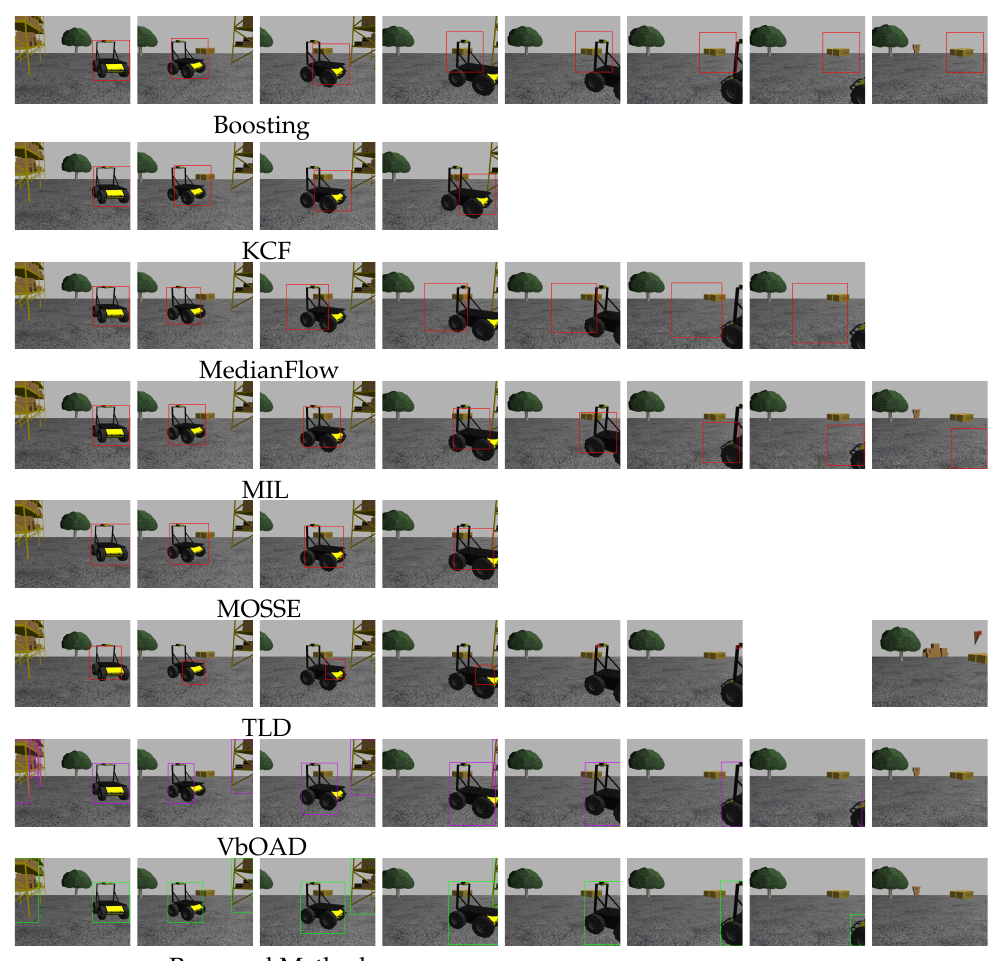
Figure 14. Similar type of experiment to that presented in Section 4.2.2. In this experiment, all RGB-based algorithms (top six rows) were initialized when the Husky2 became completely visible (first